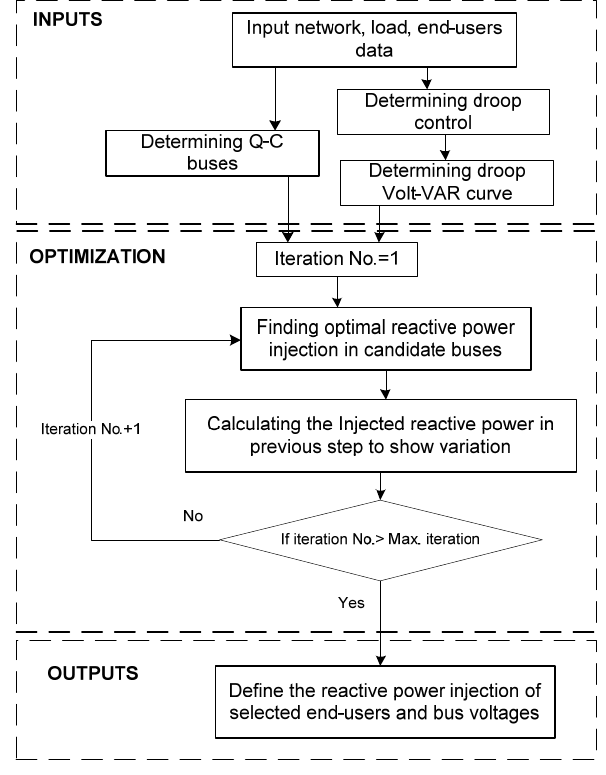
Figure 4. Schematic of the proposed algorithm.